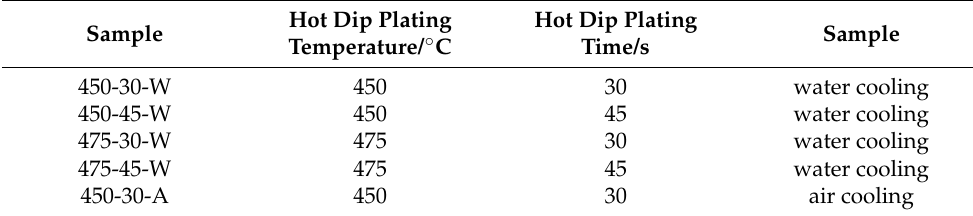
Table 4. Process parameters for hot dip plating of